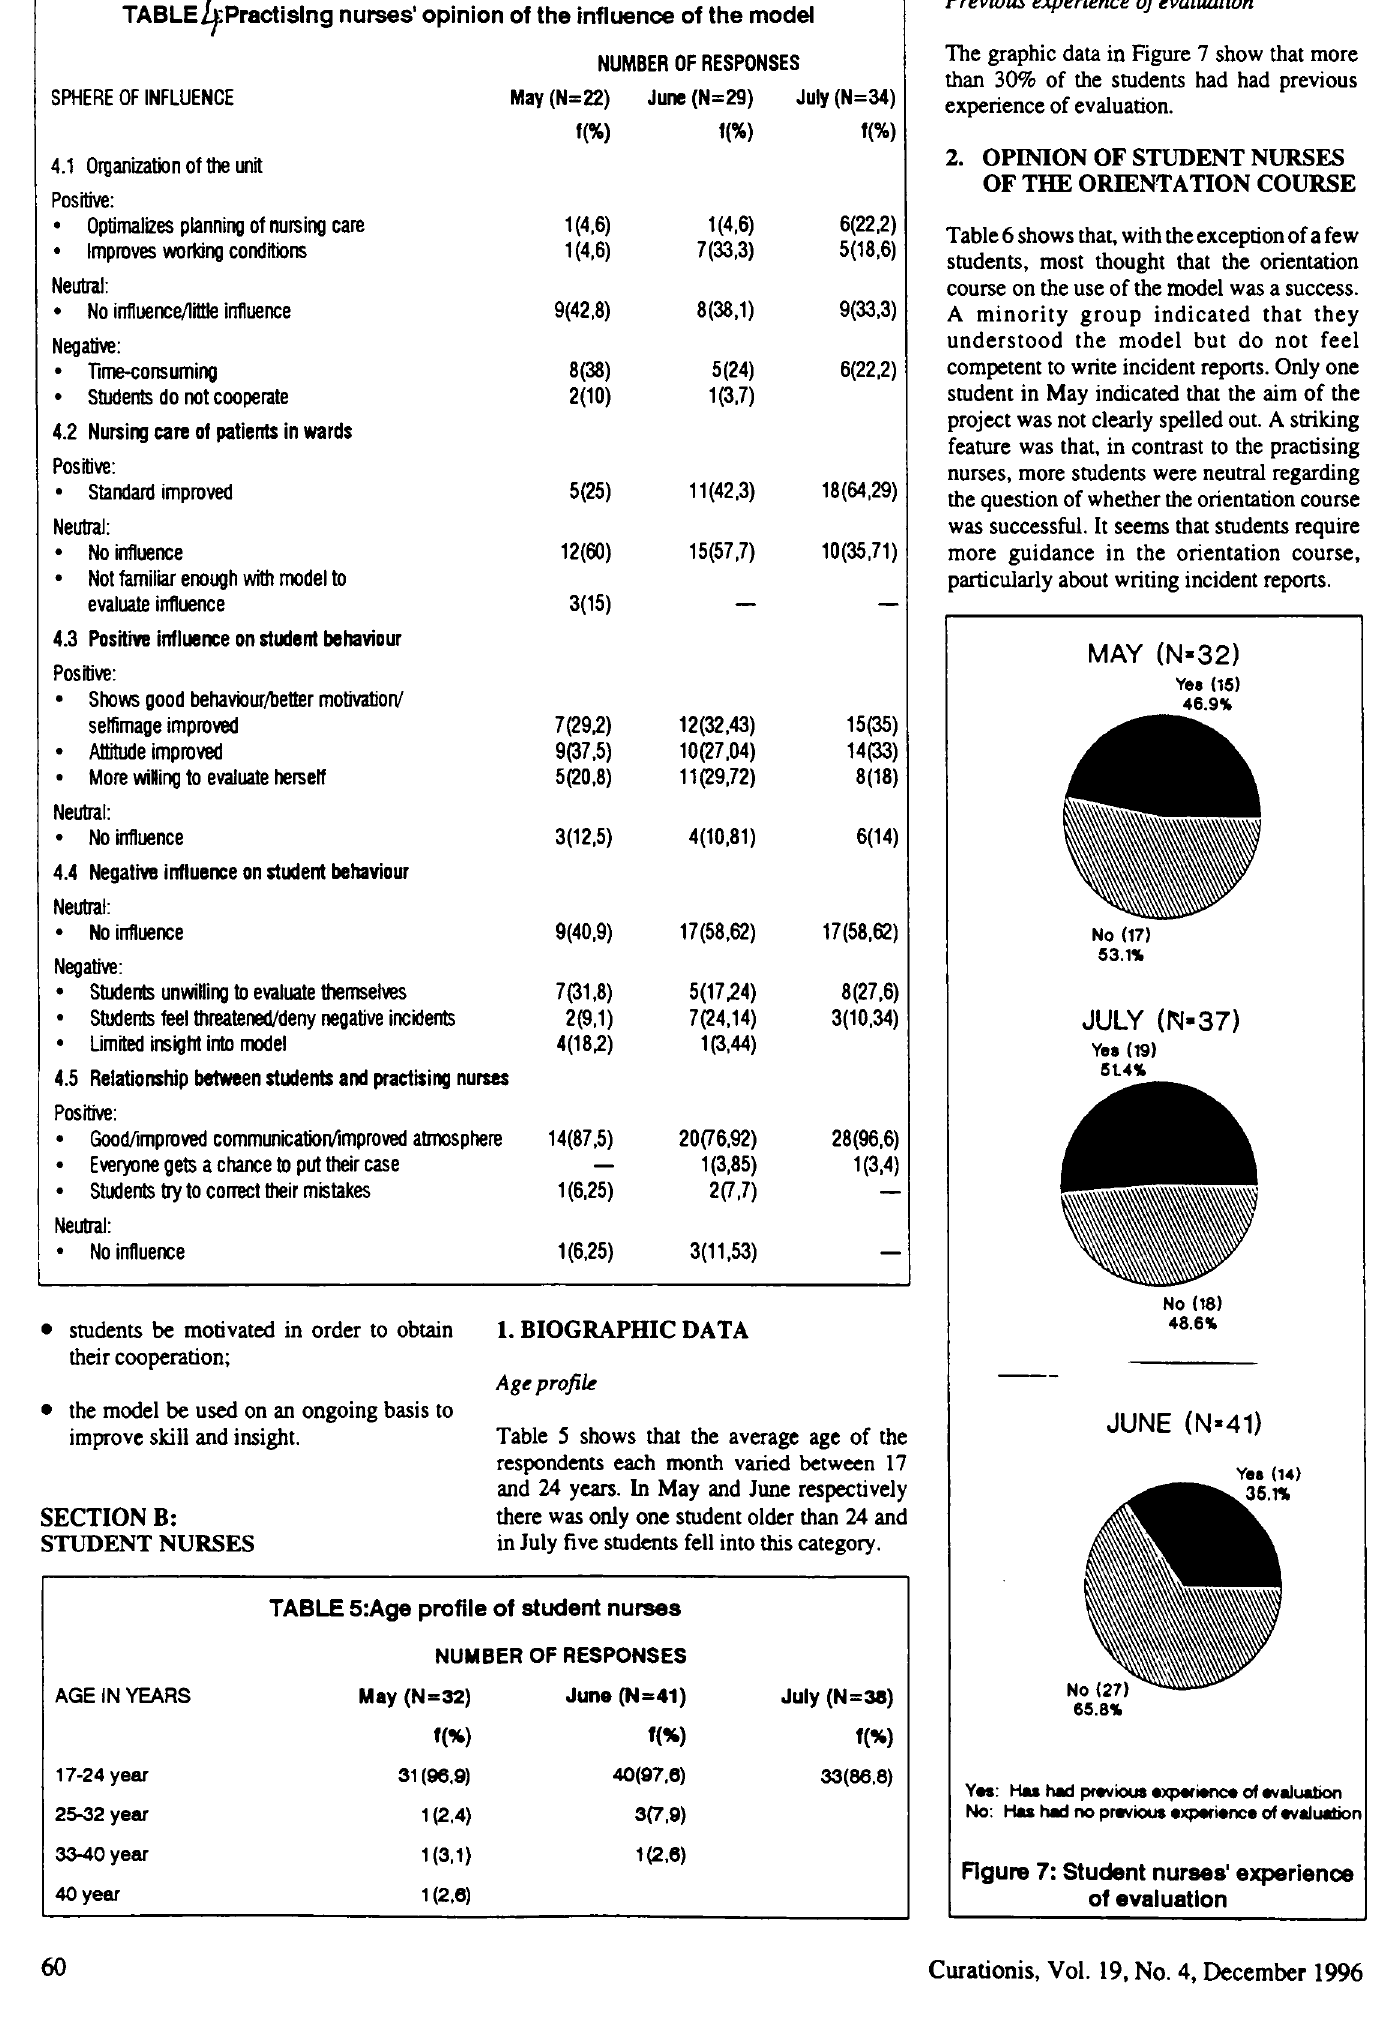
TABLE ^ :P ractlsln g n u rse s' o p in io n of the in flu en ce of the m odel